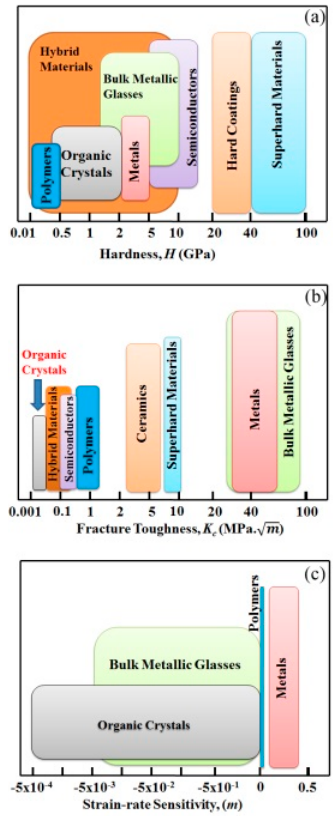
Figure 23. Schematic representation of comparison of the ( a ) hardness [2,85–90,93,98,110,113,116–122,136–140]. ( b ) fracture toughness [85,89,90,110,112,141–147], and ( c ) strain-rate sensitivity [105,106,148–152] of organic crystals with other classes of materials.